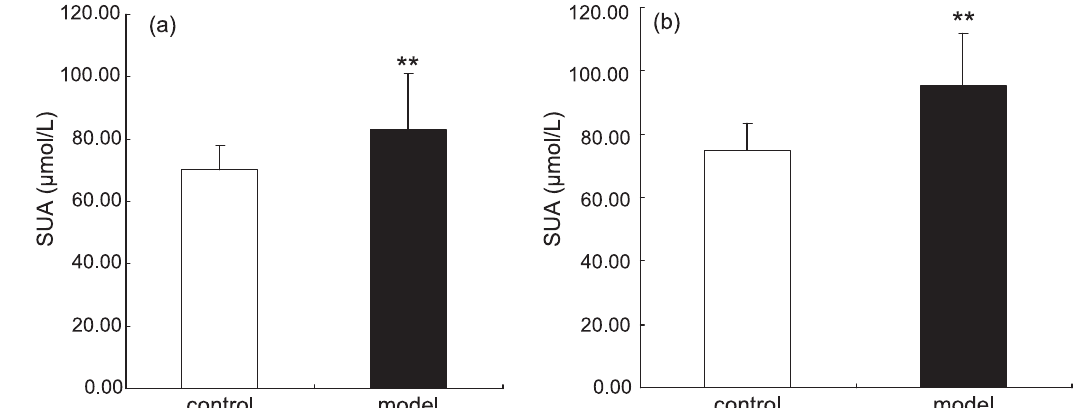
FIGURE 1 - Effect of PO treatment on rats’ SUA in different time. Data are mean ± SD, n =12. SUA, serum uric acid. (a): in 2 nd week and (b): in 4 th week. ** P<0.01 compared with control